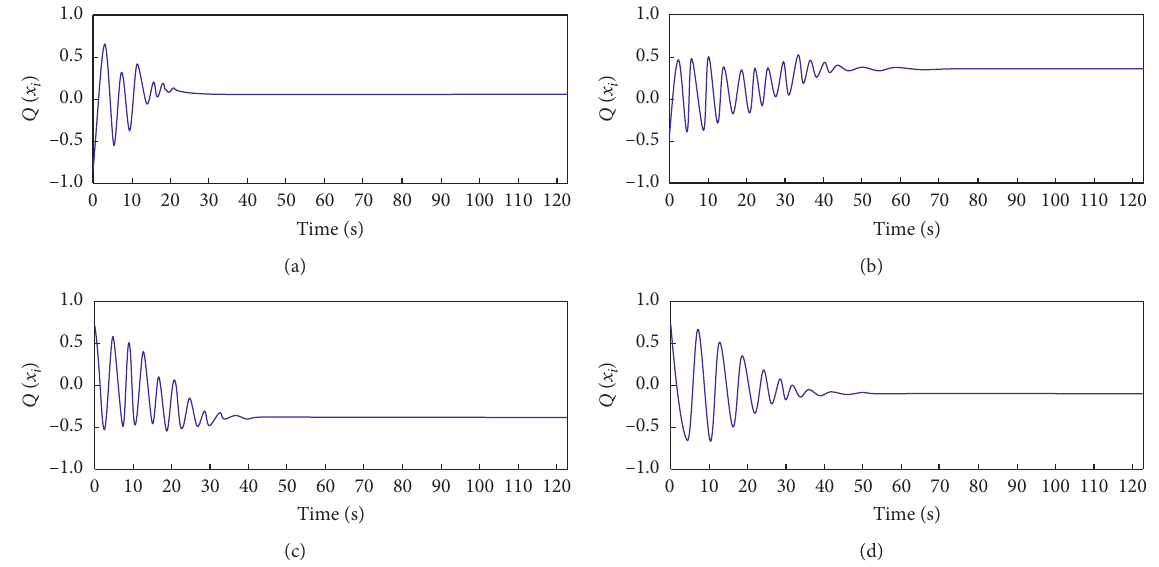
Figure 3: Relationship between total actual cost [(Q) ( x i )] and delay time with four different corresponding output variables ( τ ).